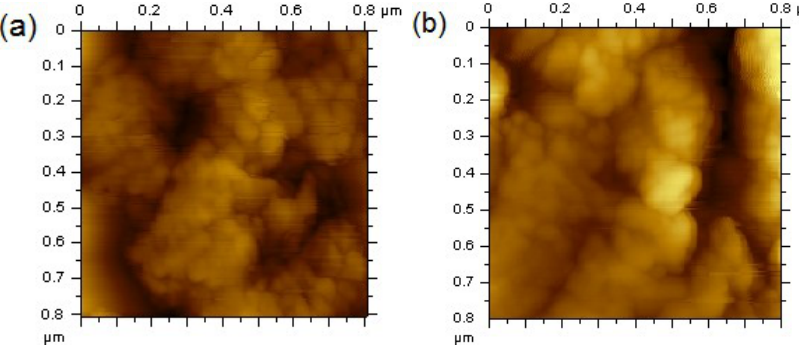
O -BD and ( b ) ZnFe 2 4